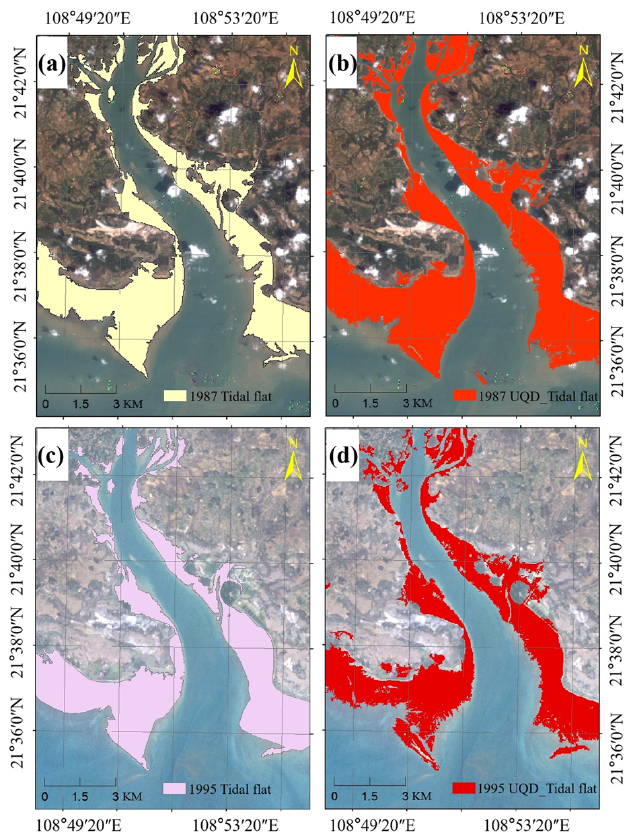
Figure 9. Comparison of tidal flats extractions with UQD data in Beihai Coast. ( a ) The 1987 tidal flats extracted by the method in this paper. ( b ) The 1987 tidal flats of UQD. ( c ) The 1995 tidal flats extracted by the method in this paper. ( d ) The 1995 tidal flats of UQD. Table 2. Total confusion matrix extracted from tidal flats from 1987 to 2021. Visual